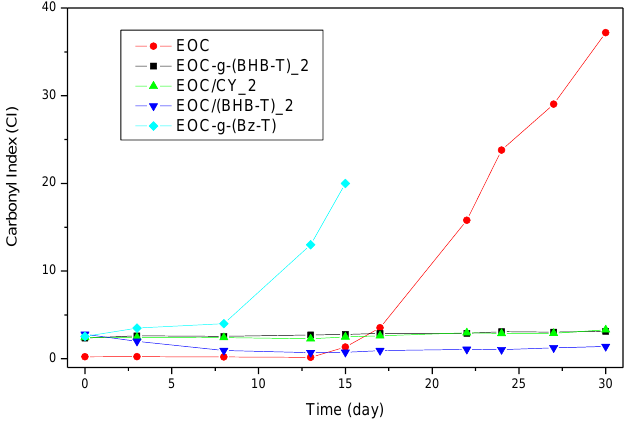
Figure 7. Carbonyl Index (CI) evolution vs. oxidation time.